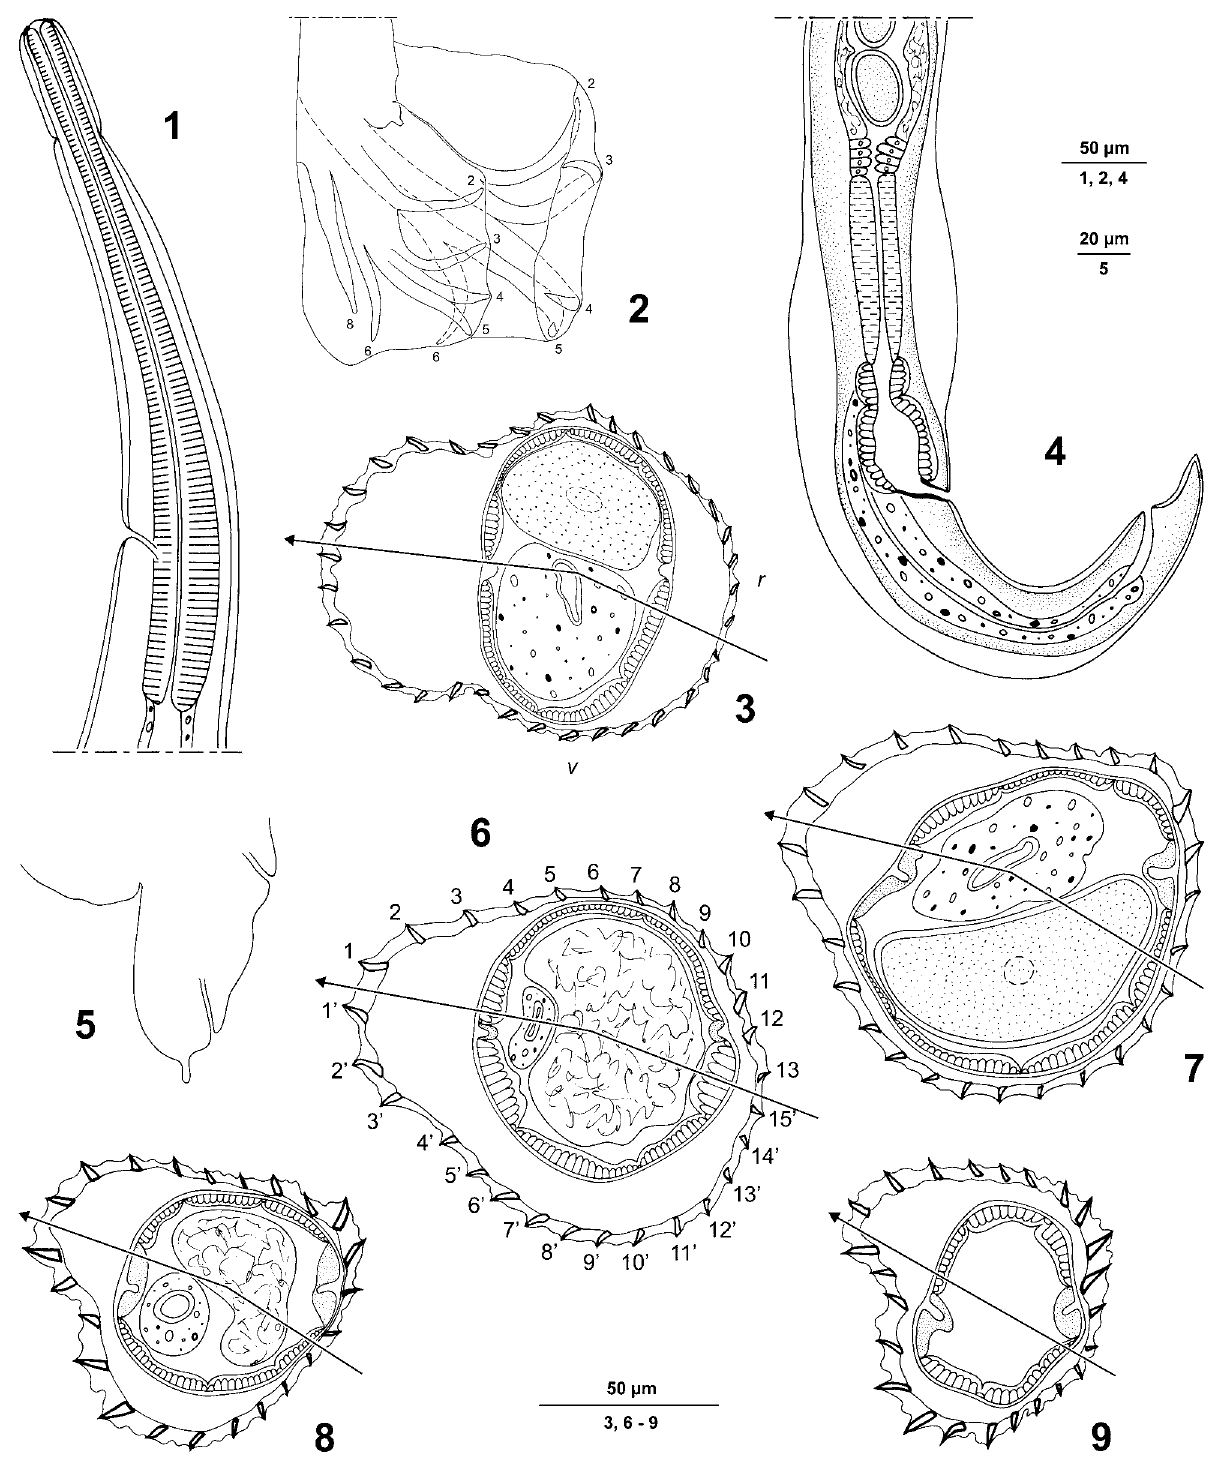
Fig. 5. – Stilestrongylus eta (travassos, 1937), CHiOC n° 9510. Female, tail, right lateral view. Figs 6, 7. – Stilestrongylus manni Denké & Murúa, 1977, paratypes, MnHn 999 Ha. transverse sections at mid-body, 6, male, at 51.9 % of body length, 7, female at 51.8 % of body length. Figs 8, 9. – Stilestrongylus valdivianus Durette-Desset & Murúa, 1979, paratypes, MnHn 710 Ca. transverse sections at mid-body, 8, male, at 46 % of body length, 9, female, at 52 % of body length. abbreviations: r, right side, v, ventral side. all sections orientated as Fig.